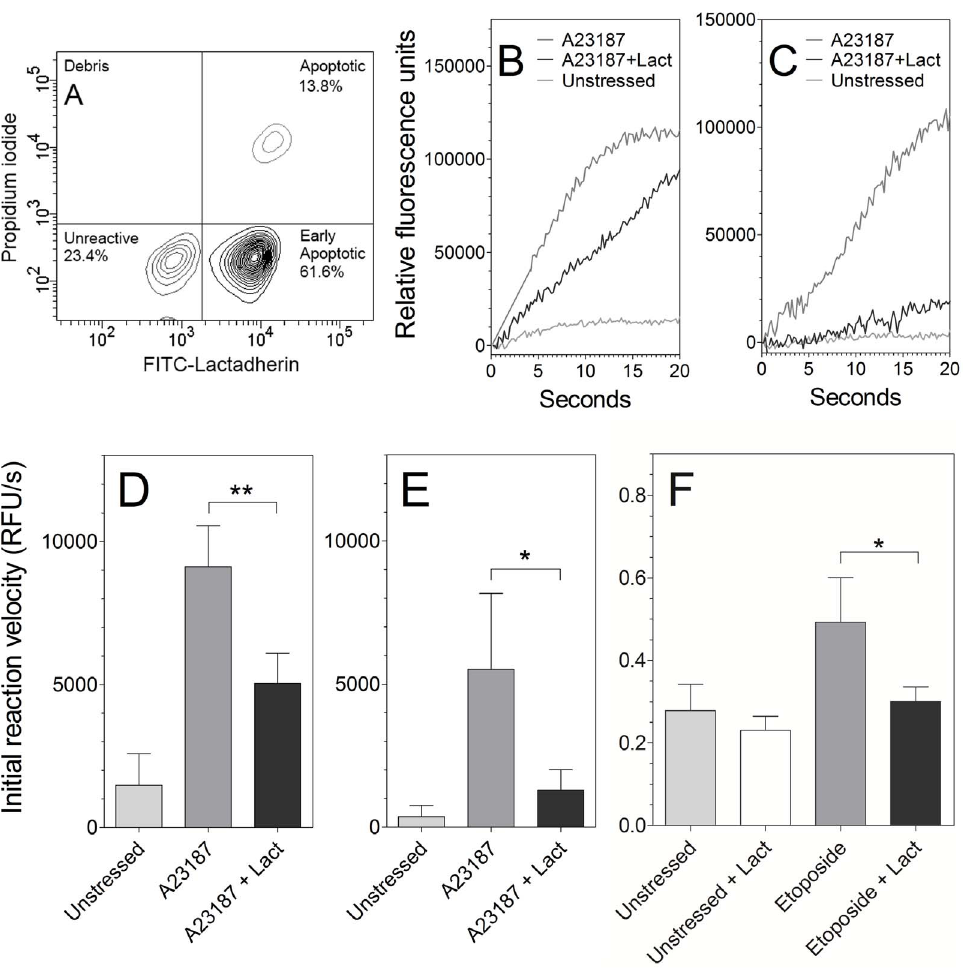
Figure 4. Inhibitory activity of lactadherin toward sPLA 2 ’s on human leukemia cells. ( A ) NB4 cells were treated with 6 m M A23187 for 10 minutes at 22 u C prior to addition of phospholipases. This treatment resulted in 61.6% pre-apoptotic cells. Phospholipase activity was detected as release of free fatty acids using the ADIFAB reagent. Each curve was run as a set in quadruplicates using a single mixture of ADIFAB and PLA 2 . Curves were run in separate sets. The initial reaction rates for nmPLA 2 and hsPLA 2 -V were calculated by linear regression to the first 5 and 15 seconds respectively, were r 2 =0.85–0.95. ( B ) 0.06 U/ml nmPLA 2 phospholipase activity on quiescent, stressed cells and stressed with 300 nM lactadherin were measured. Lactadherin was added to the cell mix immediately before adding the ionophore, proceeding with 10 minute incubation. Control curves from similar treated cells without added enzyme were subtracted as background and extrapolated Y values at injection point found using Eq. 3. Sum curves of quadruplicate sets are displayed ( C ) The experiment was repeated as in panel B using 0.06 U/ml hsPLA 2 -V. The initial reaction rate was calculated the same way as panel B. See panel 4D and 4E for quadruplicate results of nmPLA 2 and hsPLA 2 -V respectively, SD displayed with *denoting p , 0.05 and **denoting p , 0.001. To discount any adverse interactions between A23187 and lactadherin, cells were stressed using 40 m M etoposide as described in materials and methods. As seen in Figure 4F , inhibition of hsPLA 2 -V to near quiescent levels by addition of 300 nM lactadherin was observed, producing very similar inhibition ratios as found when using the quick, A23187 and lactadherin co-incubation protocol. Statistical significance using a one-tailed T-test assuming unequal variance showed a significance of p , 0.03.